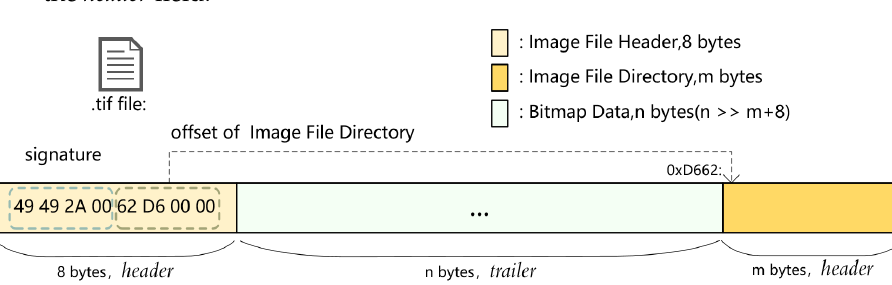
Figure 1. Layout of chunks within the .tif